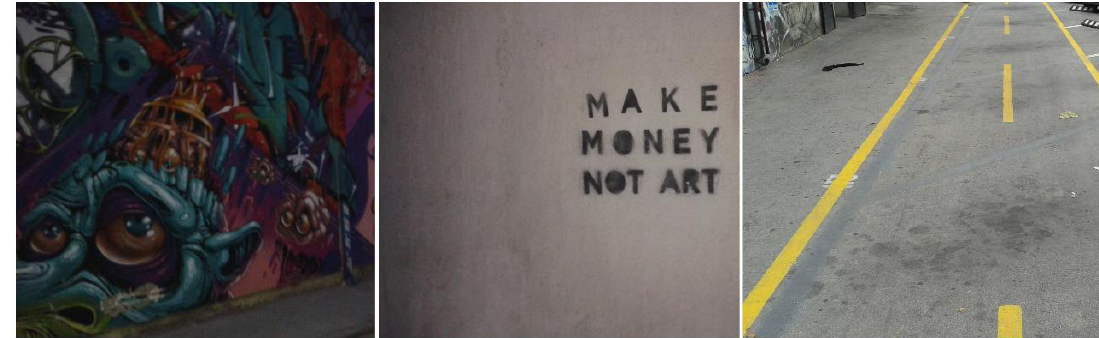
Figure 2. Street art, graffiti, and bicycle route in Savamala (source: author’s collection, August 2015).